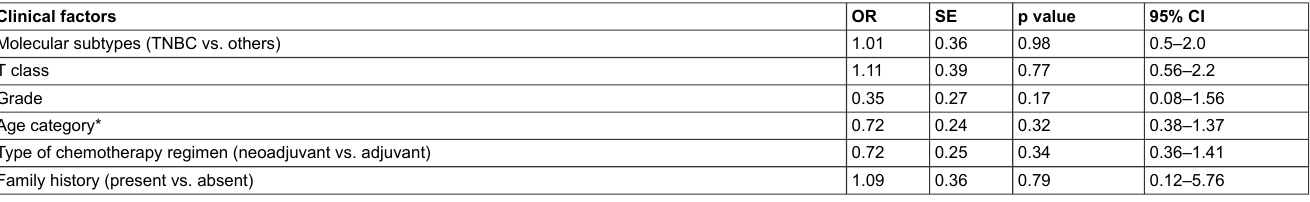
Table S1: Multivariate analysis of breast cancer patients’ characteristics, haematological toxicity during C1, and family history for gBRCA1 according to age. Clinical factors